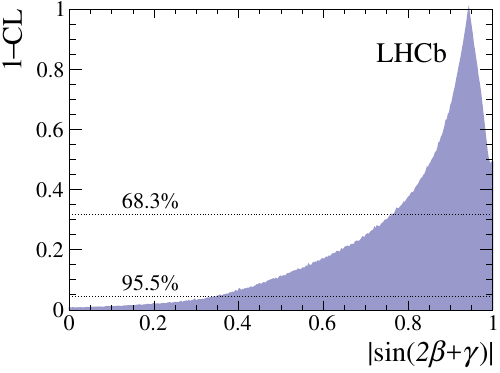
Figure 5 . 1{CL as a function of j sin(2 (cid:12) + (cid:13) ) j